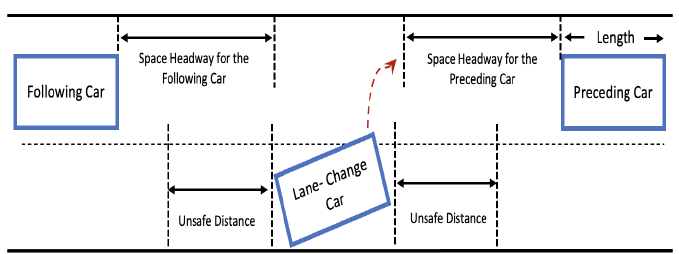
Figure 6. Basic lane-change